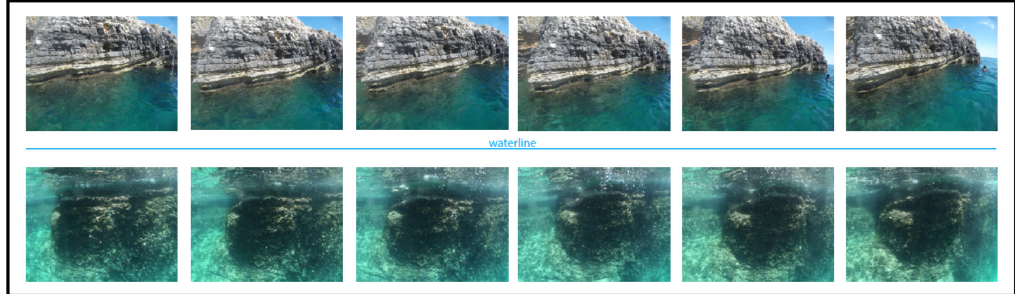
Figure 5. A set of time-lapse images collected awl and bwl at site 2 (Premantura, Croatia). Overlap exceeds 90% at the aforementioned selected swimming speeds. The system is mainly intended for corridor mapping along the waterline with a single strip. If needed, a camera inside the dome in the bow, shown in Figure 6A,C,D, at the water level can be used to film the survey operations. The distortion index in underwater photography was calibrated using a print target made using a regular W/B patch grid, shown in Figure 6B.